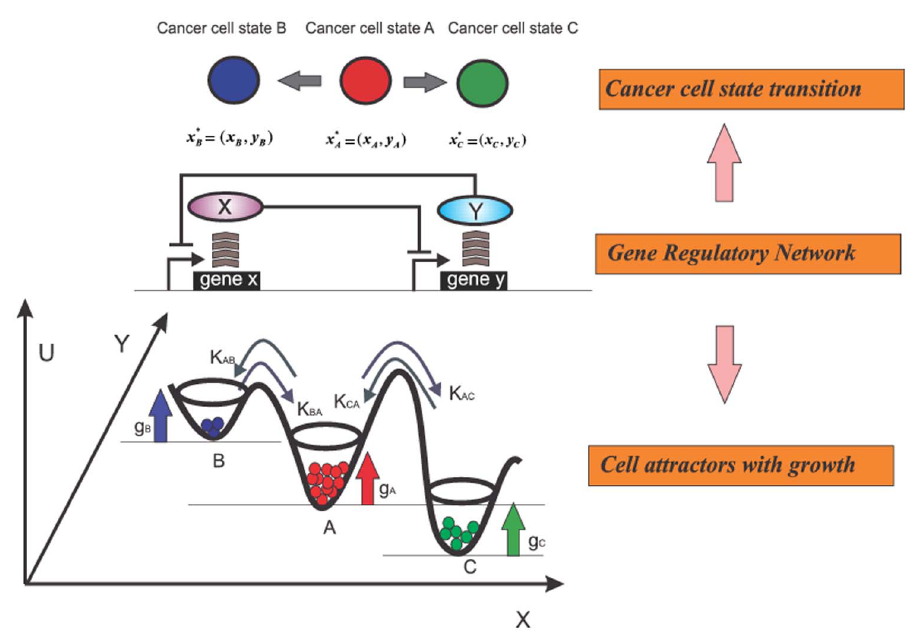
Figure 1. Schematic illustration of a cell population dynamics with three distinct cell states. A . Three cell states a , b , c with distinct gene expression x a , y a ð Þ , x b , y b ð Þ and x c , y c ð Þ . B . The gene regulatory circuit of X and Y determines three cell states a , b , c . C . Each state is associated with a growth rate g a , g b , g c respectively. Three states transition to each other with the interconversion rates k ab , k ba , k ac , k ca , k bc , k cb .